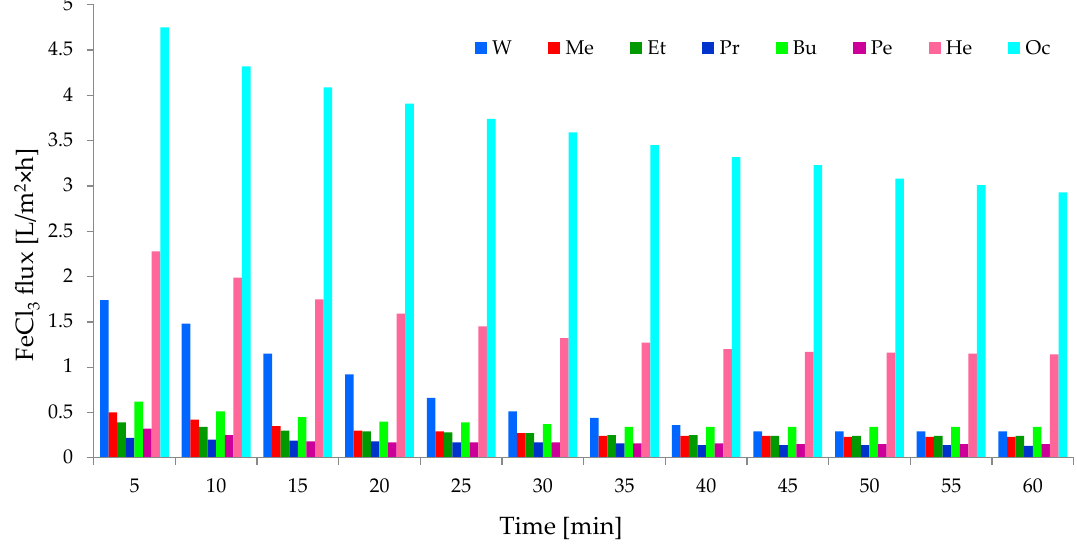
Figure 12. Volumetric permeate flux for the solution of FeCl 3 .